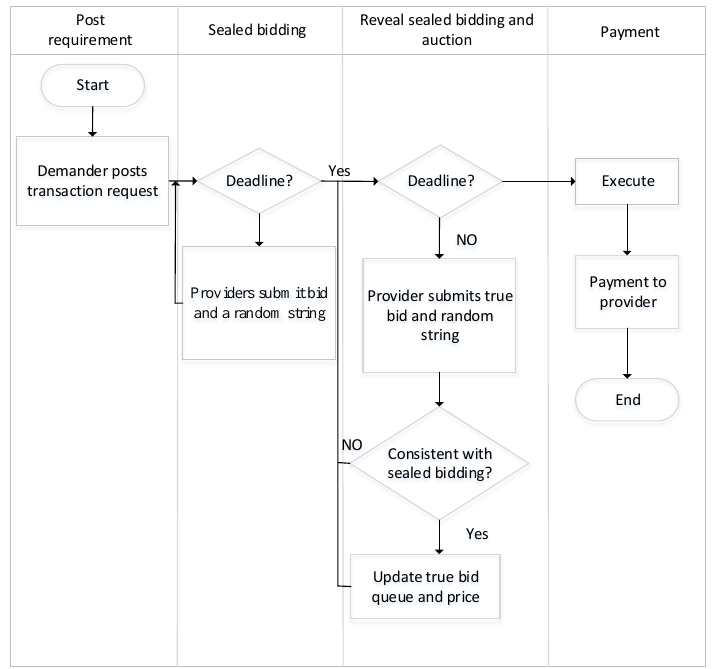
Figure 3. The diagram of transaction process based on smart